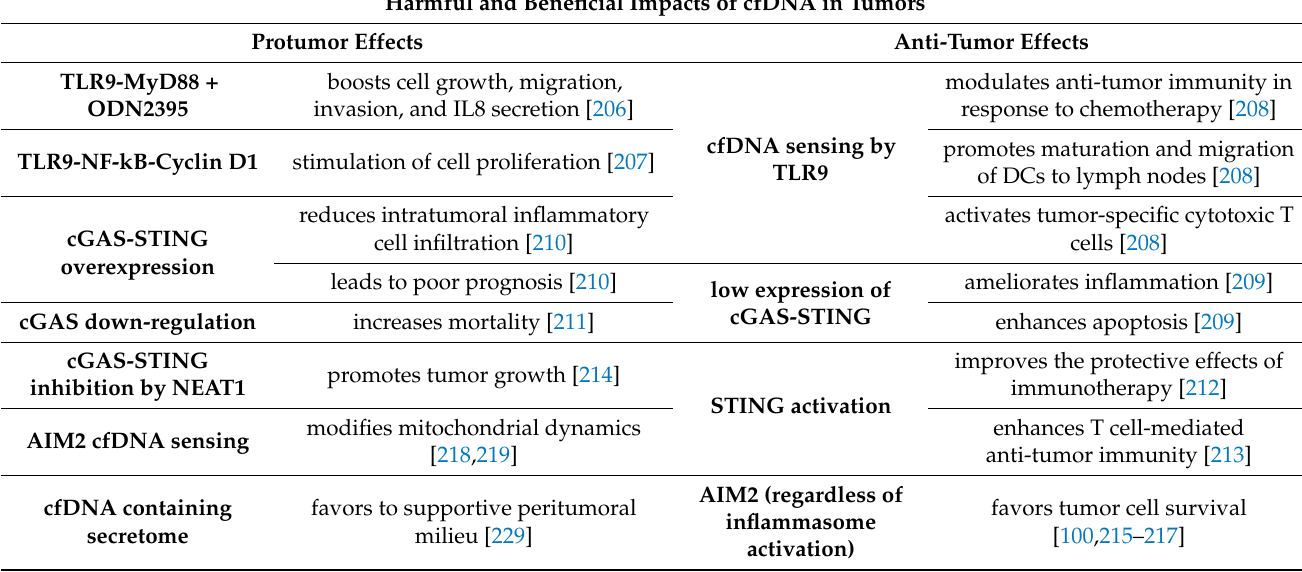
Table 1. The possible effects of cfDNA on tumor